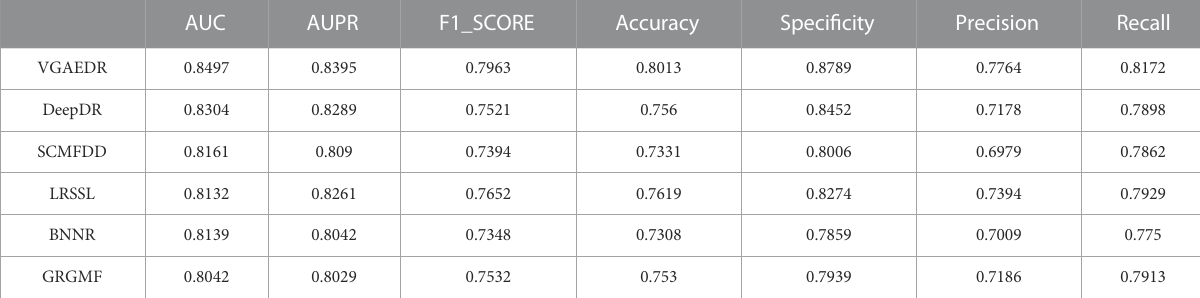
TABLE 3 Performance of comparison methods on Dataset1.